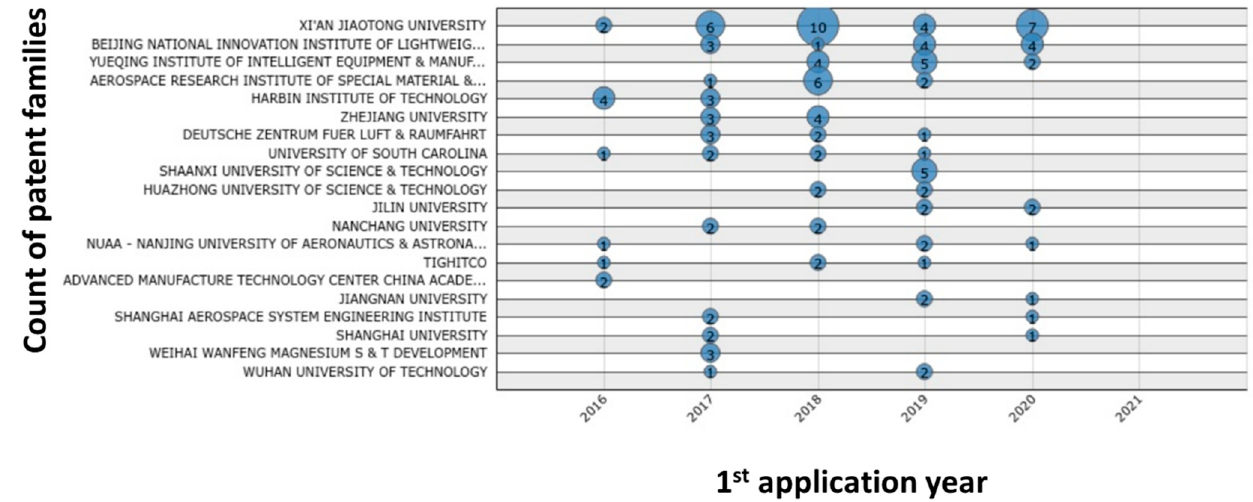
Figure 15. Main technology domains covered by the 10 largest private assignees in FFF adapted to CFRTPC printing in February 2021.